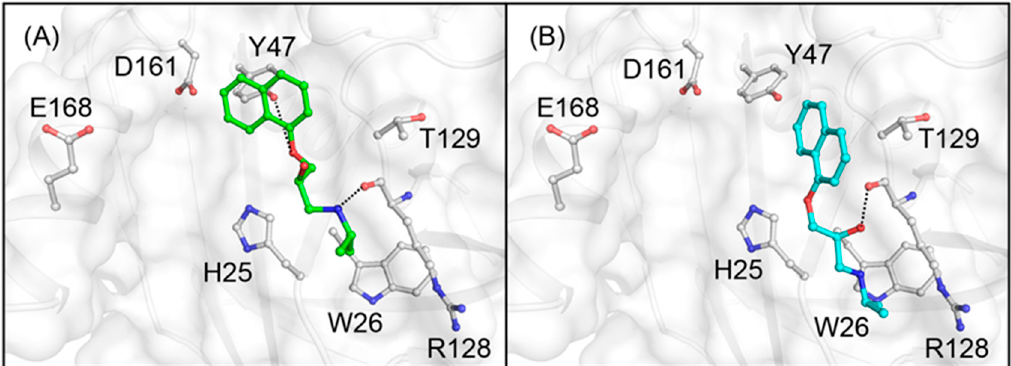
Figure 5. Simulated docking structures of cAGP with ( A ) ( R )-propranolol and ( B ) ( S )-propranolol. The docked compounds were represented as in Figure 3. Besides, the same colors were used for nitrogen and oxygen atoms, and the remarked amino acid residues as in Figure 3. Feasible interactions were depicted as dotted lines.